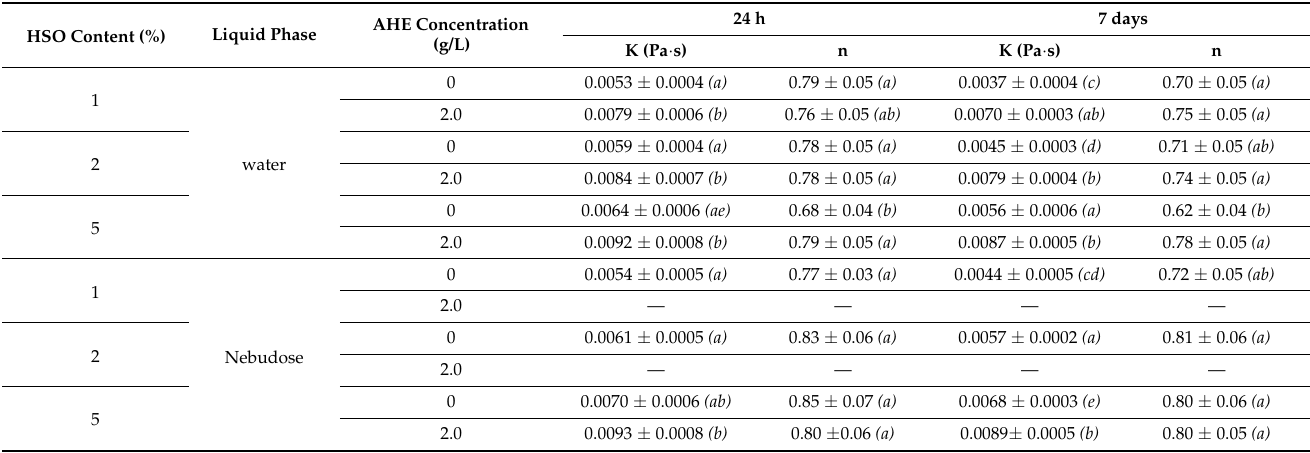
Table 4. Average value and SD of the parameters of the power model describing the viscosity curves of the O/W emulsions: consistency coefficient (K), flow index